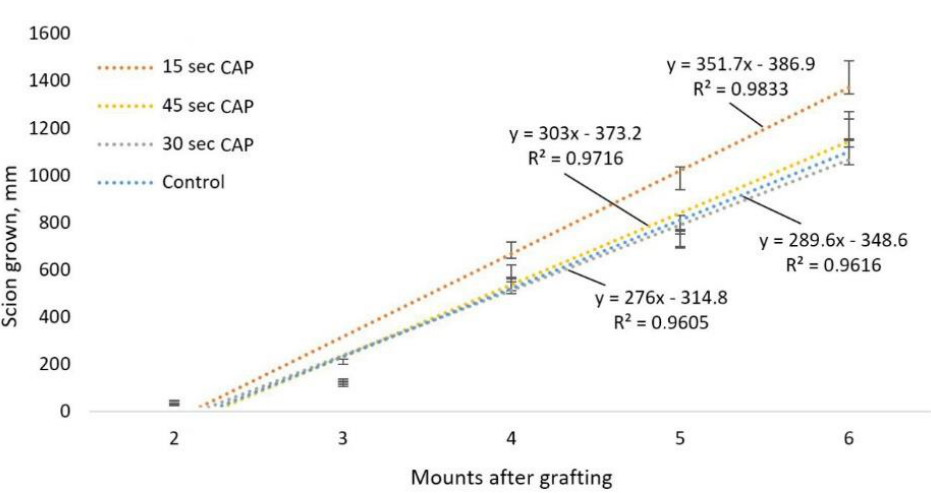
Figure 8. The dynamics of the growth of cherry seedlings of the “ Revna ” variety within 4 months after planting in the greenhouse with direct treatment and different durations of exposure to CAP (15 s, 30 s and 45 s).